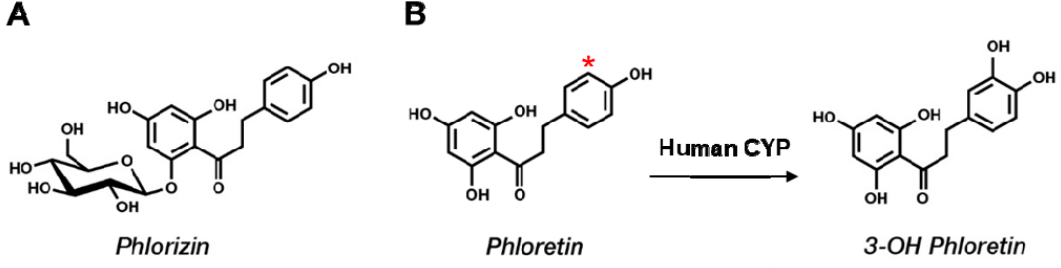
Figure 1. Chemical structures of phlorizin, phloretin, and 3-OH phloretin. ( A ) Phlorizin is a major glucoside form of phloretin. ( B ) Phloretin’s conversion to its product is catalyzed by human cytochrome P450 (P450) in the presence of reduced β -nicotinamide adenine dinucleotide phosphate (NADPH). A star (*) marks the hydroxylation site on phloretin catalyzed by P450.